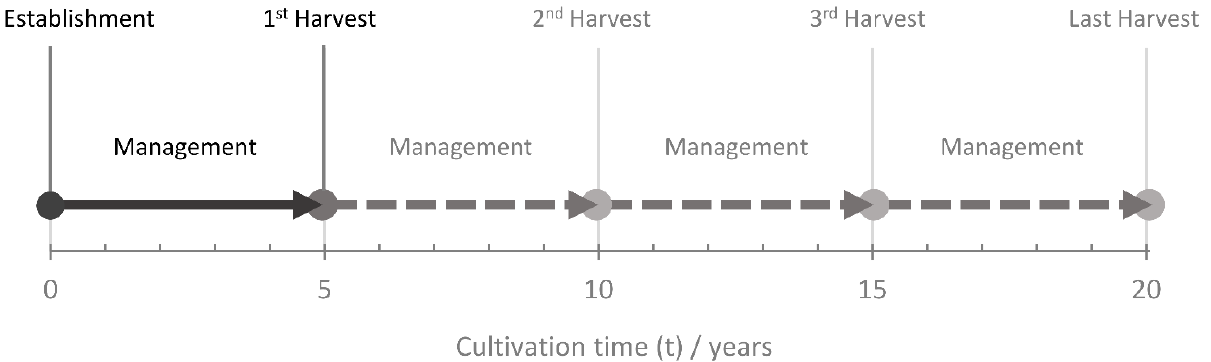
Figure 2. Timeline of the first five years of Sphagnum farming on former bog grassland (dark grey) (Rastede, Lower Saxony) and assumptions for repeated harvests with a rotation length of five years and a total cultivation time of 20 years (light